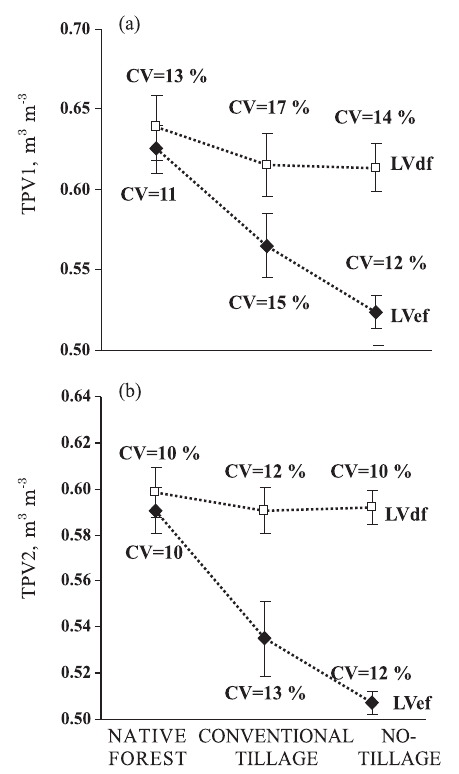
Figure 1. Average values (for 20 replications with 10 samples per profile at each sampling site) and confidence interval (95 %) (a) of the total pore volume of 300 cm 3 soil blocks (TPV1) and (b) of 10 cm 3 soil clods (TPV2), collected in the LVdf and LVef (dystroferric and eutroferric Red Oxisols) in the 5–50 cm layer, representing the crop profile.